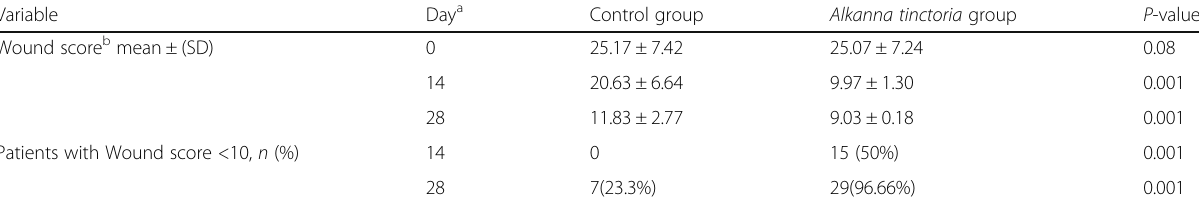
Table 2 Score comparison and surface area between the groups